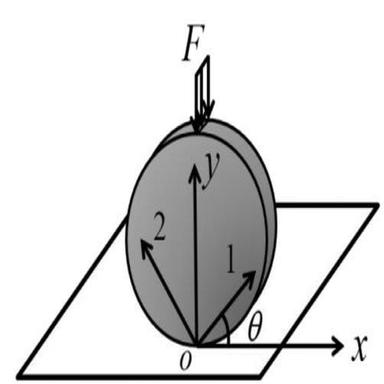
Schematic diagram of a diametrically compressed disk configuration.